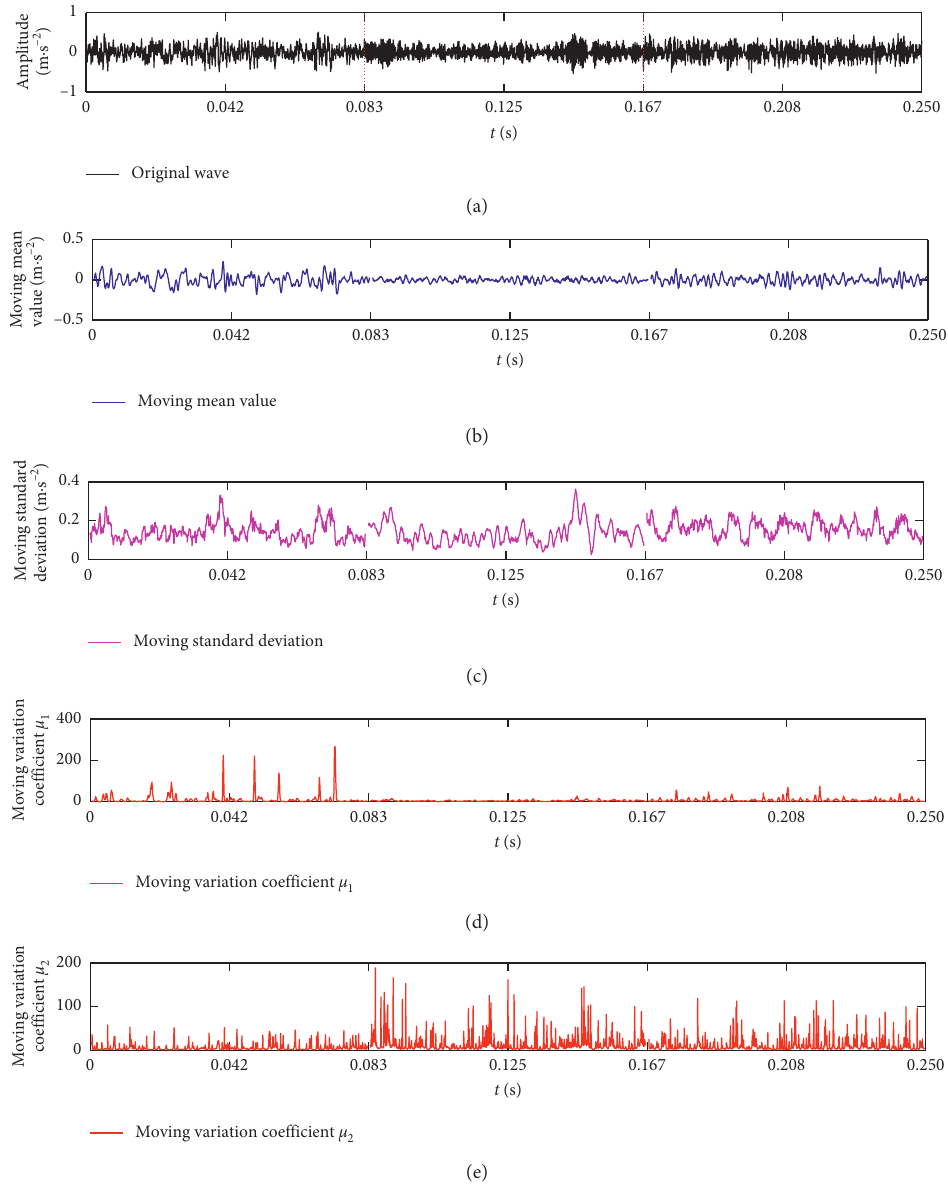
Figure 5: Analysis of mechanical fault signals based on moving algorithms.